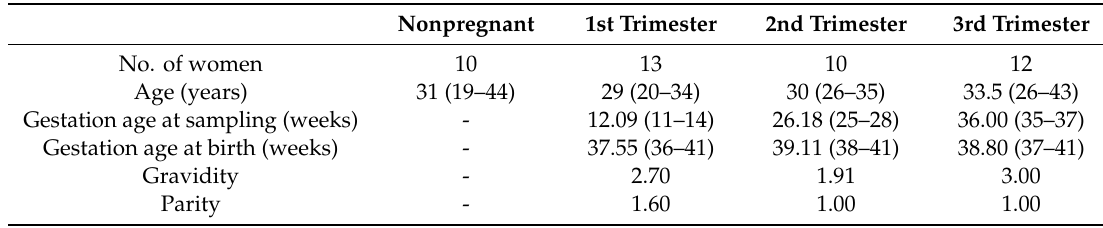
Table 1. Gynecological and demographic data of the participating